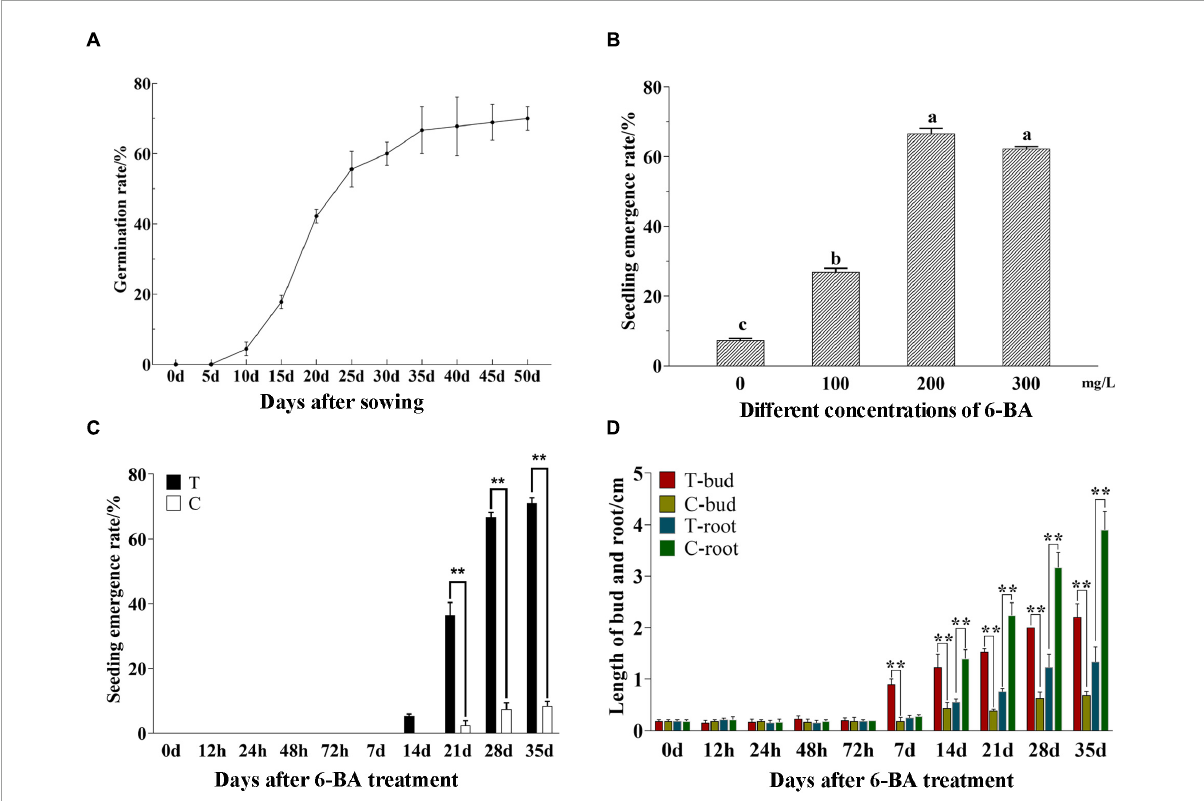
FIGURE1 Determination of morphological indexes of seed germination and emergence of P. cyrtonema . (A) Germination rate of P. cyrtonema seeds at different times after sowing. (B) Effect of 6-BA treatment on seed germination rate of P. cyrtonema . Different letters indicated significant differences ( p < 0.05) among different concentrations. (C) The emergence rate at different times after sowing. (D) The changes in bud length and root length of seeds after 200 mg/L 6-BA treatment. The concentration of 6-BA was 200 mg/L, and T represents the treatment group while C represents the control group in the same period. T-bud and T-root, respectively, represent the bud length and root length after 6-BA treatment; C-bud and C-root, respectively, represent the bud length and root length of the control group in the same period. “**” indicates that the difference is very